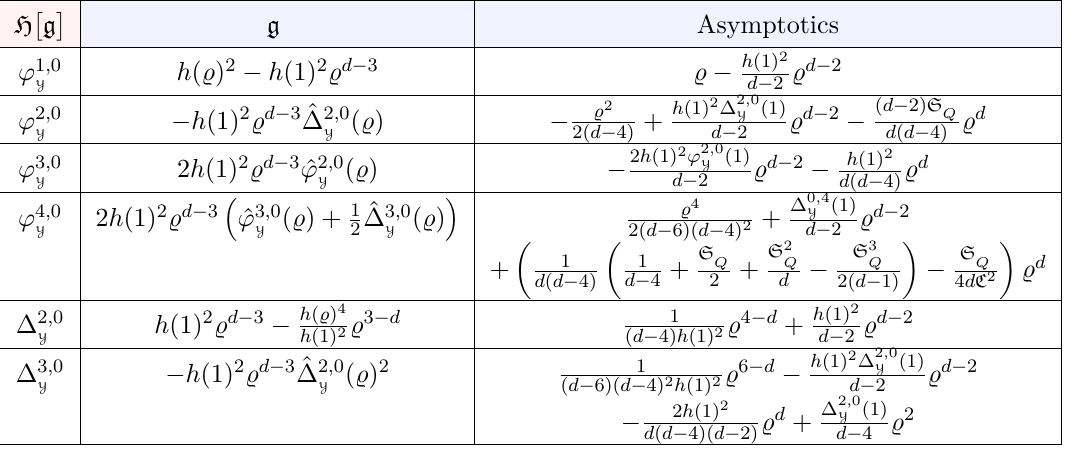
Table 1 . Functions used to parameterize the gradient expansion of the Markovian transverse photon modes in [1]. We have collected the essential functions defined using the integral transform (C.3). We also indicate the leading asymptotic behavior; note that only the last two functions diverge as % → 0 .